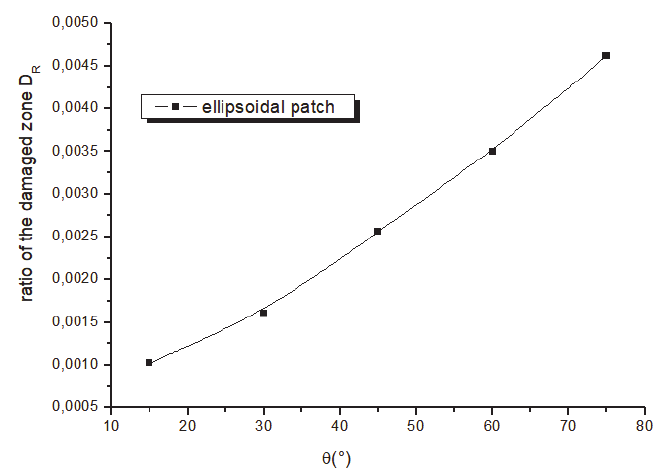
Figure 11: Ratio of the damaged zone according to the crack